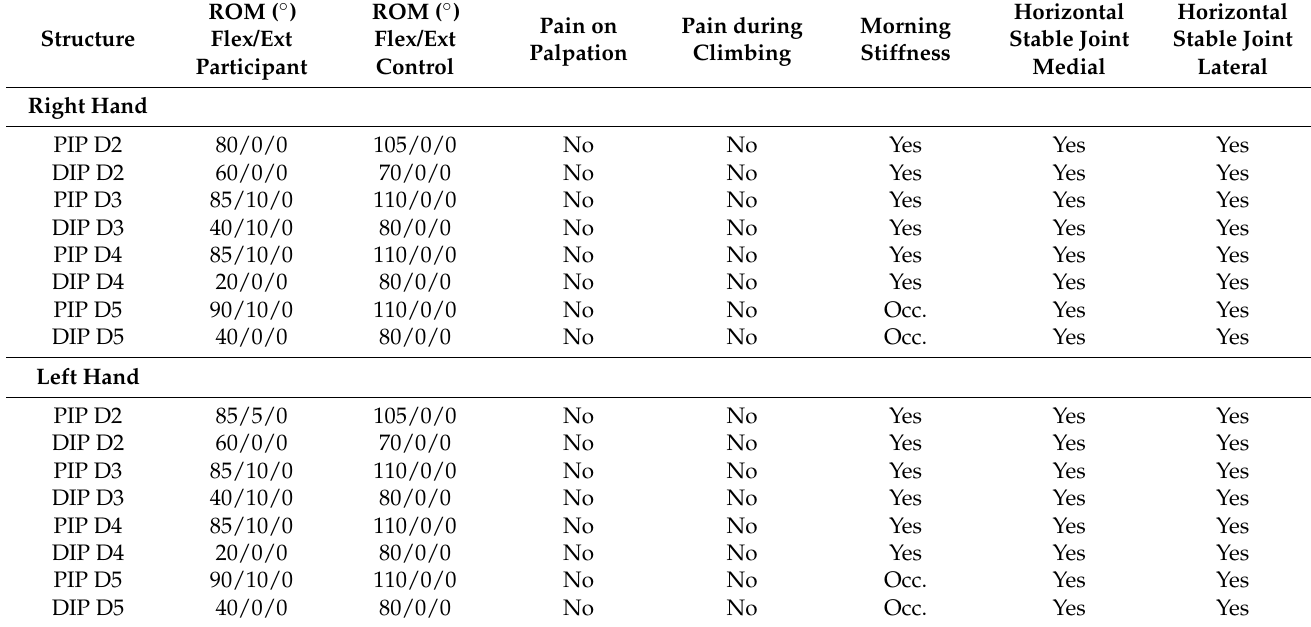
Table 2. Participant’s clinical investigation of digits II-V of both hands. Column 2 shows the range of motion of a non-climbing weight- and height-matched control to demonstrate normal values. Horizontal stability of the joints was assessed to test the ulnar and radial collateral ligament